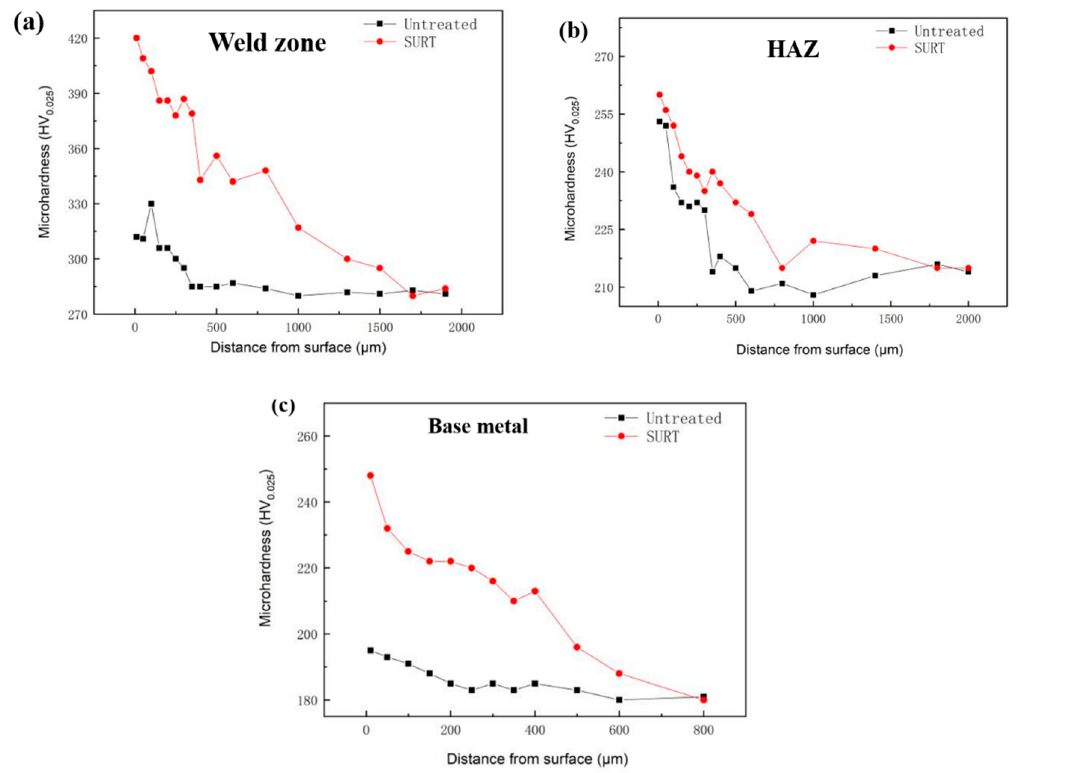
Figure 6. The variation of hardness of T4003 ferritic stainless steel welded joint at different depth from surface before and after SURT. ( a ) Weld zone. ( b ) HAZ. ( c ) Base metal.